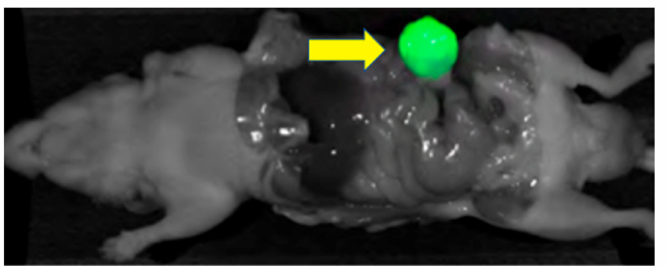
Figure 3. BxPC3 pancreatic orthotopic mouse model after receiving M5A-SW-IR800 (75 µ g). The arrow points to the brightly labeled tumor